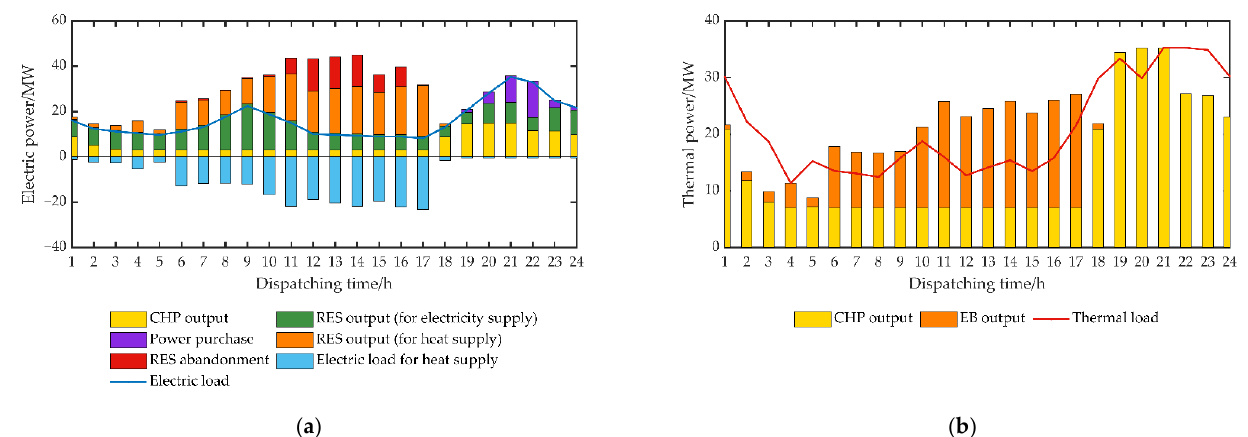
100 Table 2. The parameters of CHP in different functional areas. Functional Area